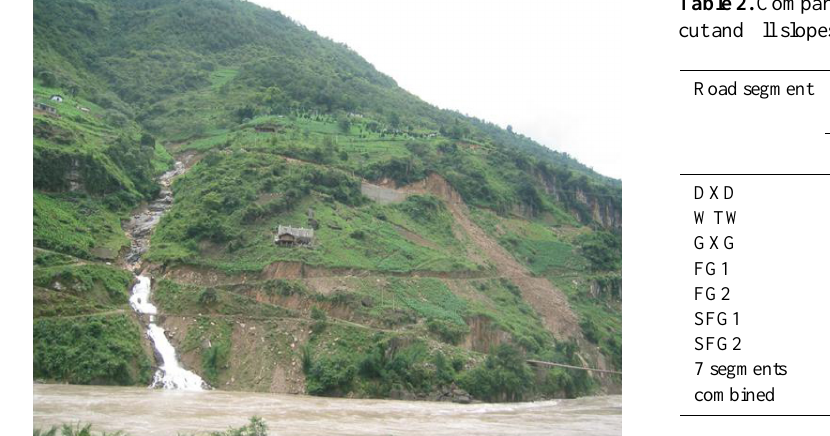
Figure 3. Road leading to a mountain village on the west side of the Salween River about 45km south of Fugong. Upper portion of the road had (SFG1) the lowest landslide erosion of all surveyed segments, while the lower portion of the road (SFG2) had fewer numbers of, but larger, cut slope failures. Landslide erosion rates were significantly higher at SFG2 compared to SFG1 – 3.5 times higher for fill slope and 4.4 times higher for cut slope failures. The access bridge across the river is in the lower right corner of the photo.